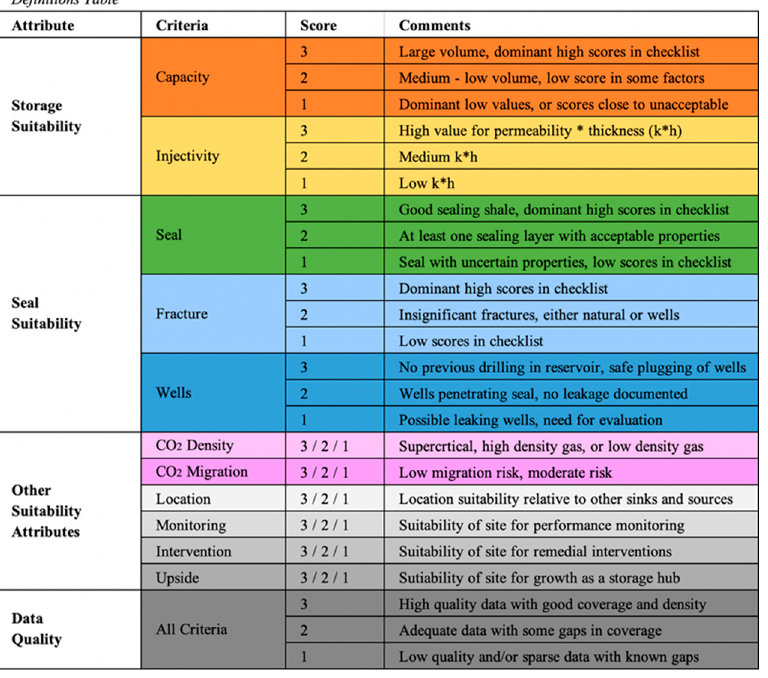
Figure A2. Attribute list for Boston square analysis [71,82].